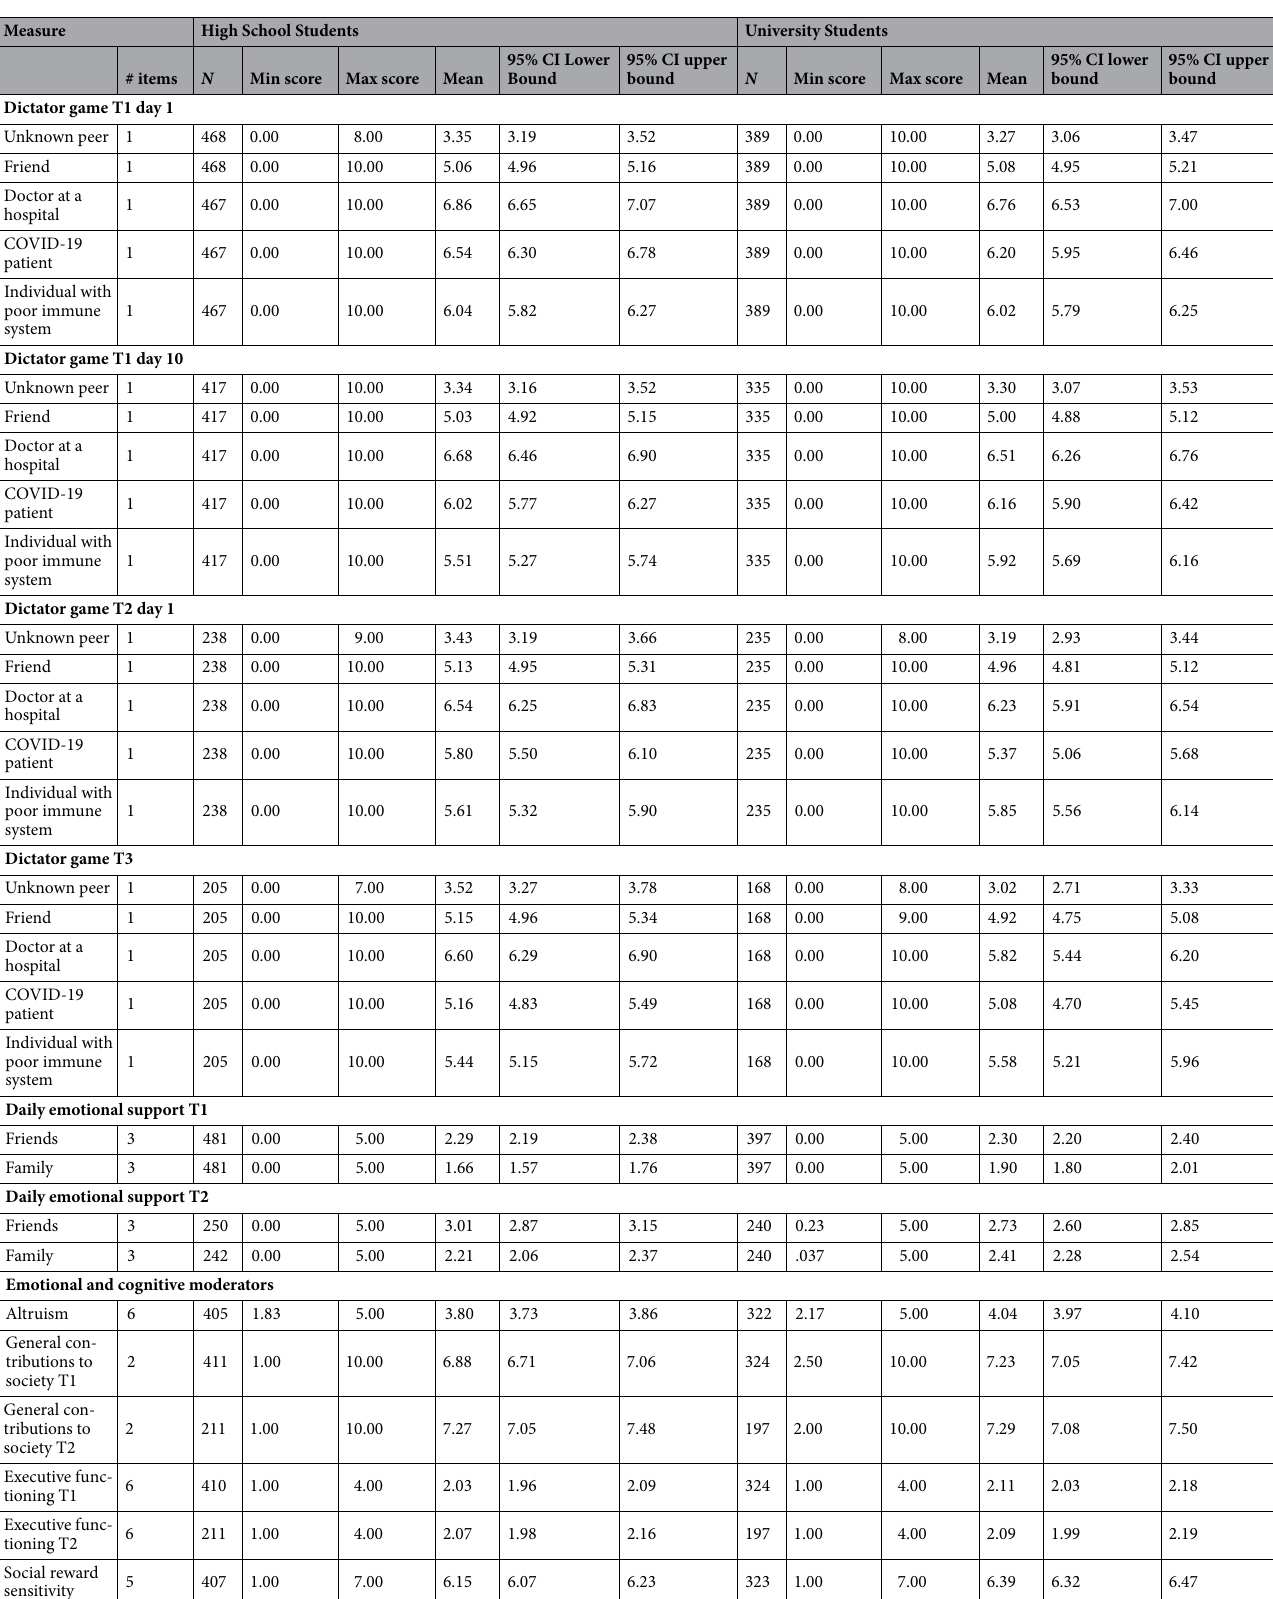
Table 1. Descriptive statistics of giving, daily emotional support, altruism, self-control, emotion awareness, general contributions to society, executive functioning, and social reward sensitivity at all timepoints (T1, T2, and T3). The minimum and maximum scores indicate the actual responses (i.e., not potential responses) to the